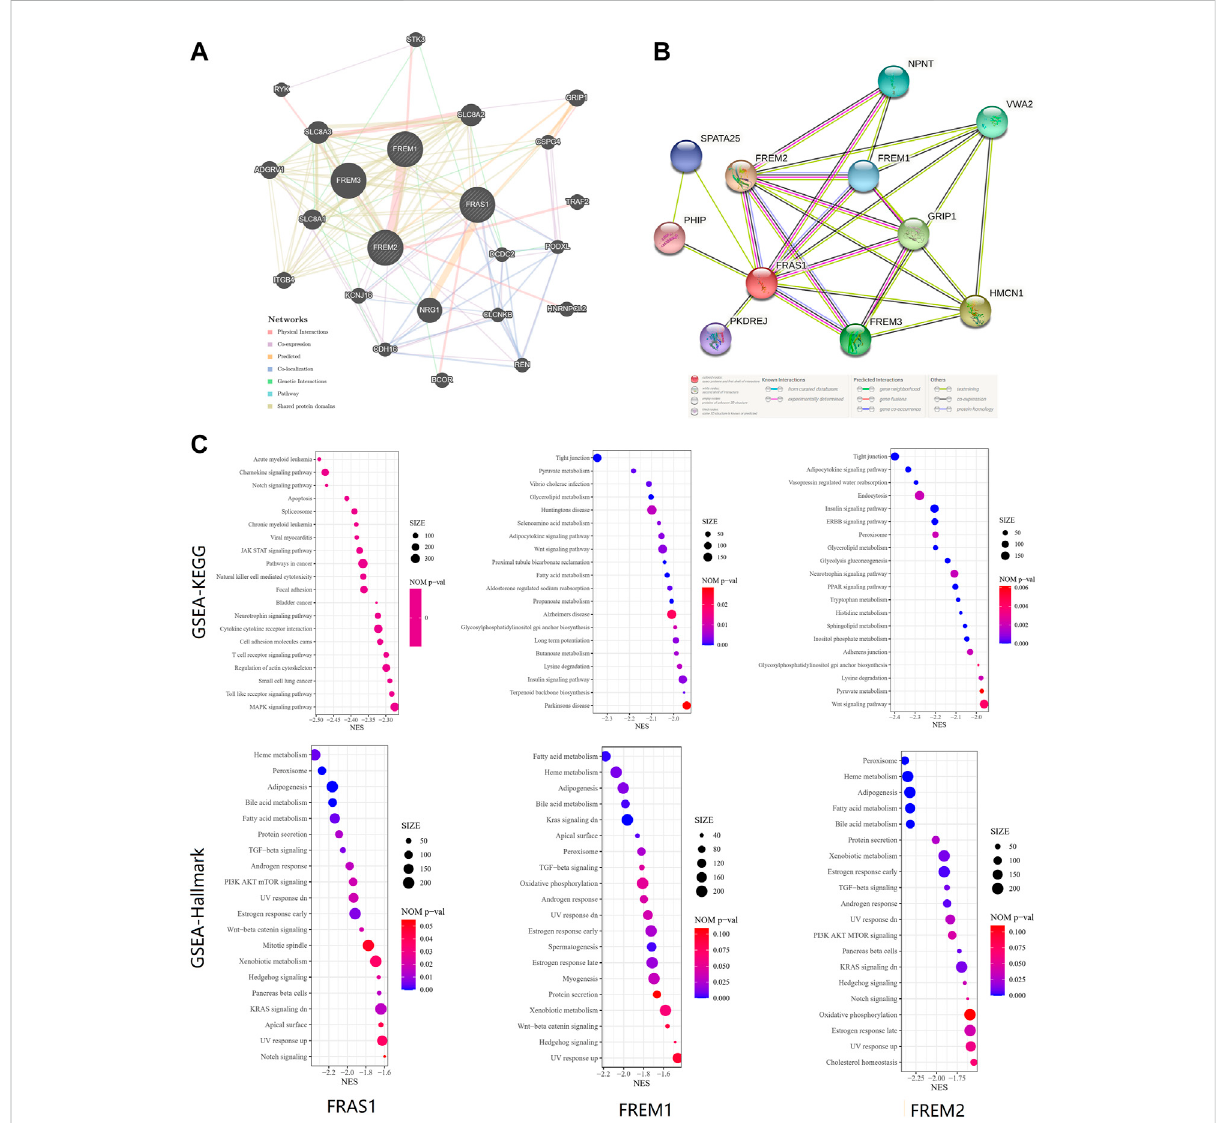
FIGURE 10 FRAS1/FREM-related gene enrichment, pathway analysis and function pro fi les. (A) PPI network analysis of FRAS1/FREM family members and their 20 co-regulated hub genes conducted by GeneMANIA. (B) STRING protein network map of experimentally determined FRAS1/FREM-binding proteins. (C) Signi fi cant gene set enrichment analysis (GSEA) results of FRAS1, FREM1 and FREM2 including KEGG pathways and Hallmark